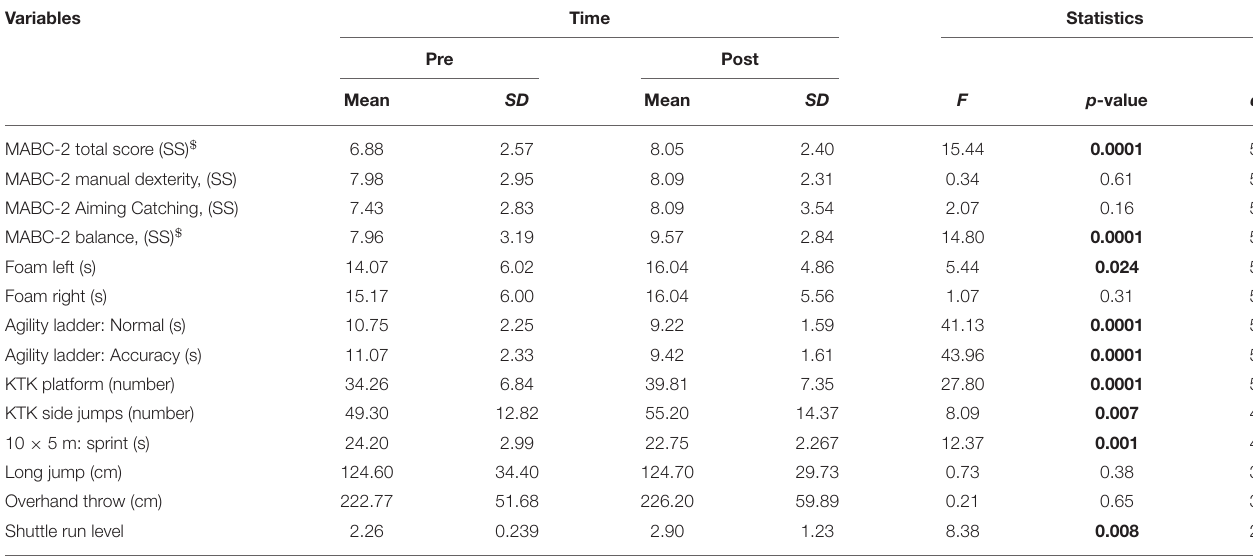
TABLE 3 | Comparison of motor and fitness performance before and after training (mean, standard deviation, F -value for the main effect of Time, p -values, and degrees of freedom). Variables